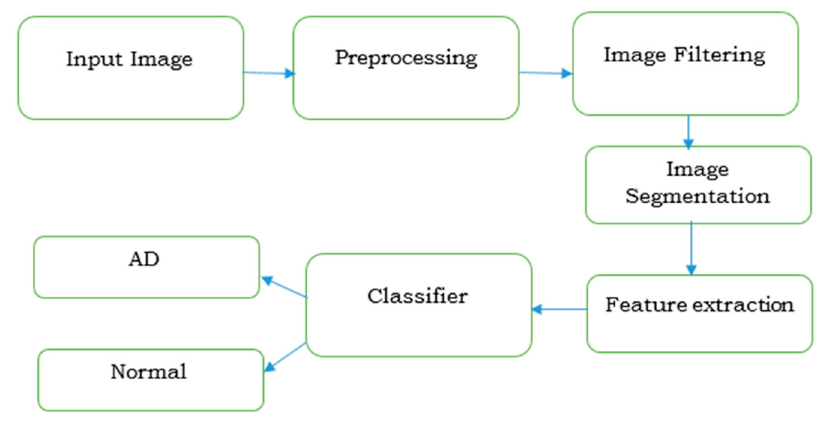
Figure 5. Imaging procedure for diagnosing Alzheimer’s disease.